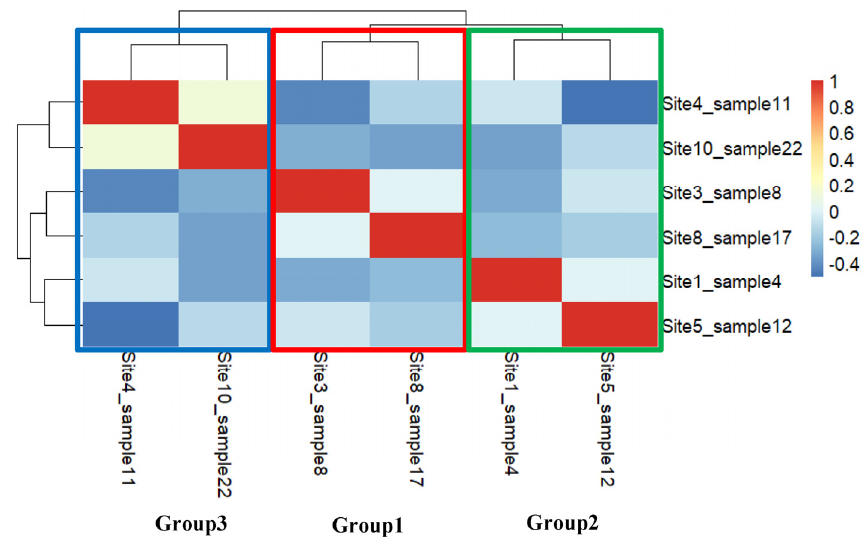
Figure 11. Heatmap analysis of Ricinus communis combined traits (vegetative morphometry, leaf micromorphology, soil analysis, and GC-MS analysis).